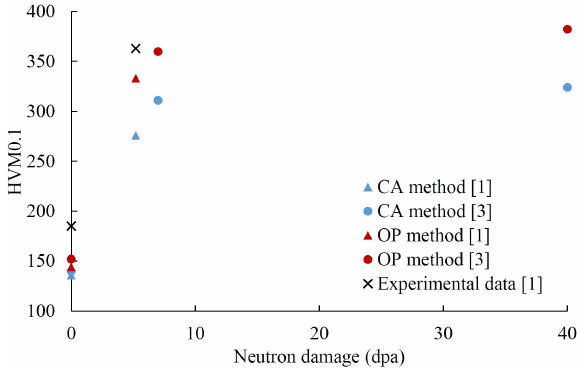
Figure 5. Dependence of Vickers hardness on neutron damage for different hardness evaluation methods: contact area (CA), Oliver-Pharr (OP) [4] method